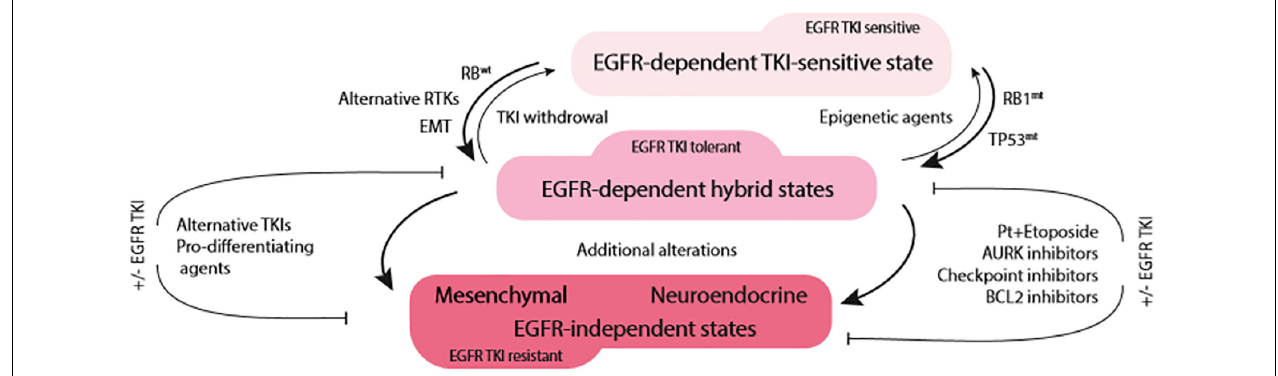
FIGURE 2 | Acute EGFR TKI exposure drives phenotypic plasticity and TKI tolerance in EGFR -mutant NSCLC. The route to therapeutic resistance appears to be dependent on RB1 status. In RB1-wild type tumors (RB1wt), transition toward mesenchymal phenotype with activation of alternative tyrosine kinases (RTKs) is likely to occur (left side of the diagram). On the other hand, RB1-mutant/TP53-mutant ( RB1 mt, TP53 mt) tumors are likely to undergo neuroendocrine transformation (right side of the diagram). This hybrid, EGFR TKI-tolerant state appears to be still dependent on EGFR signaling and may revert to EGFR TKI-sensitive phenotype upon EGFR TKI withdrawal or epigenetic therapies. With prolonged treatment, due to additional genomic alterations, tumors lose their dependence on EGFR signaling and lock in the terminal state of EGFR TKI